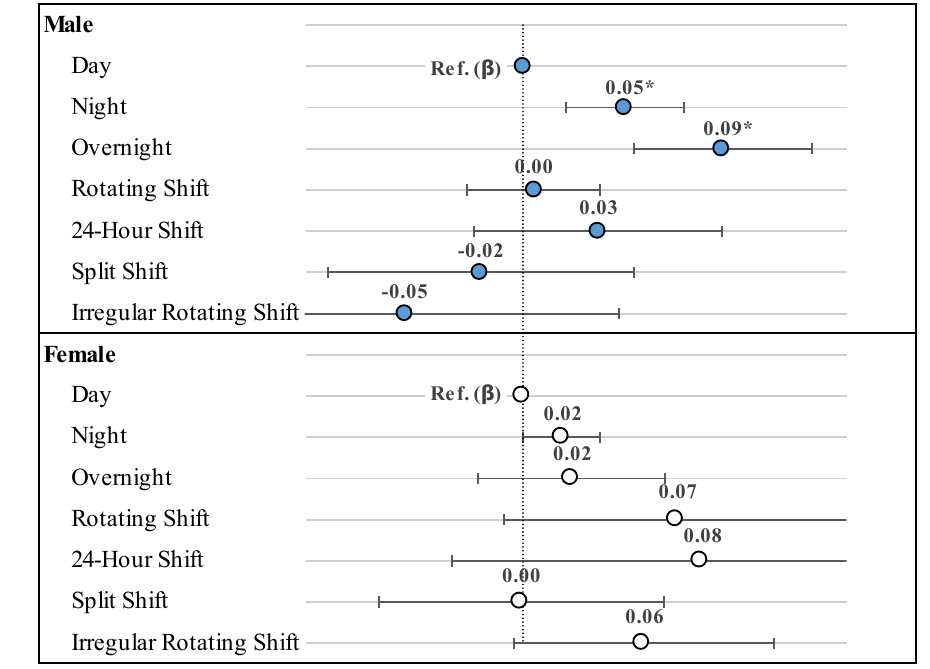
Figure 1. Generalized multiple linear regression for HbA1c levels according to the specific types of work schedules; * p -value < 0.05.